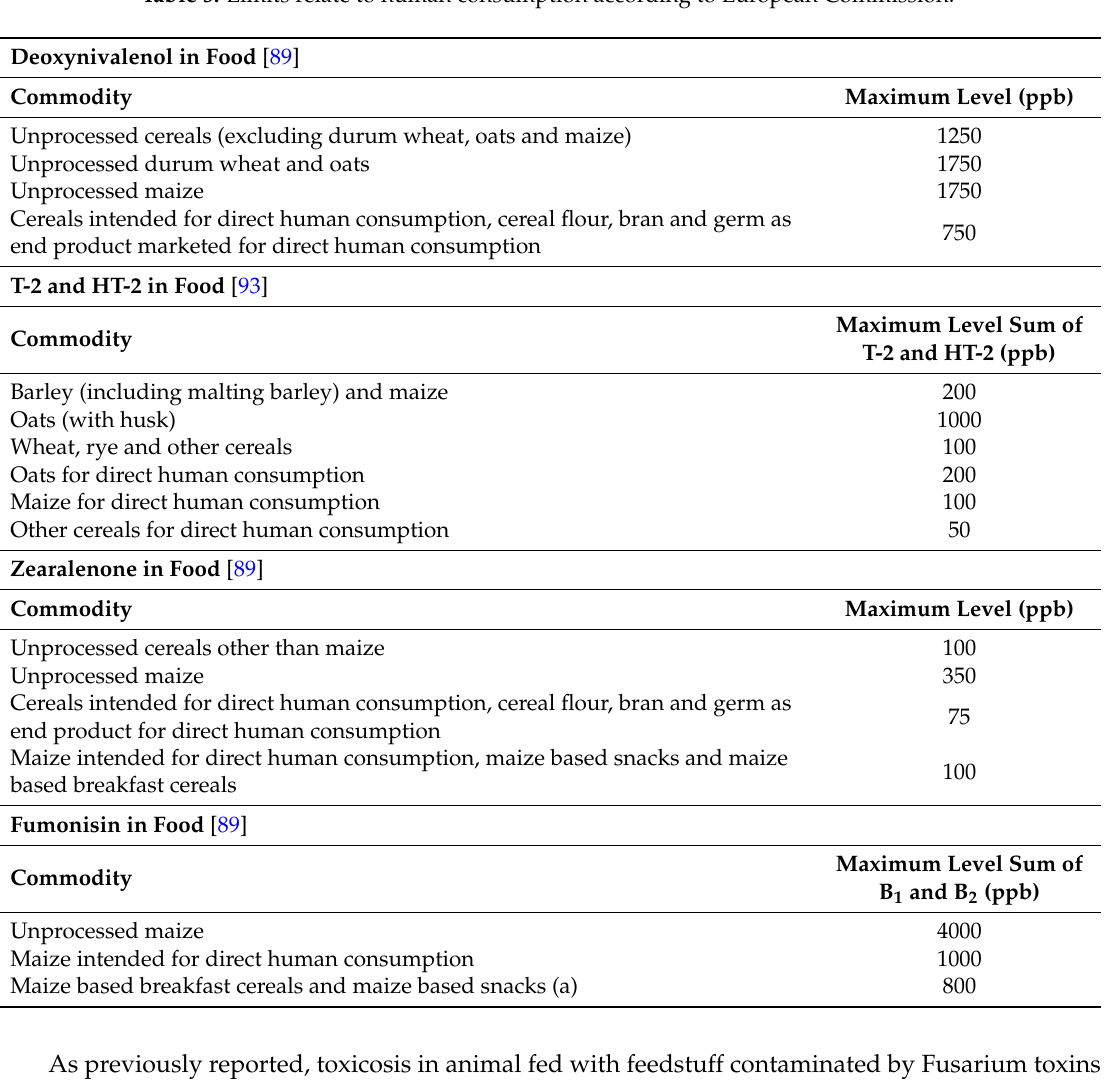
Table 5. Limits relate to human consumption according to European Commission.